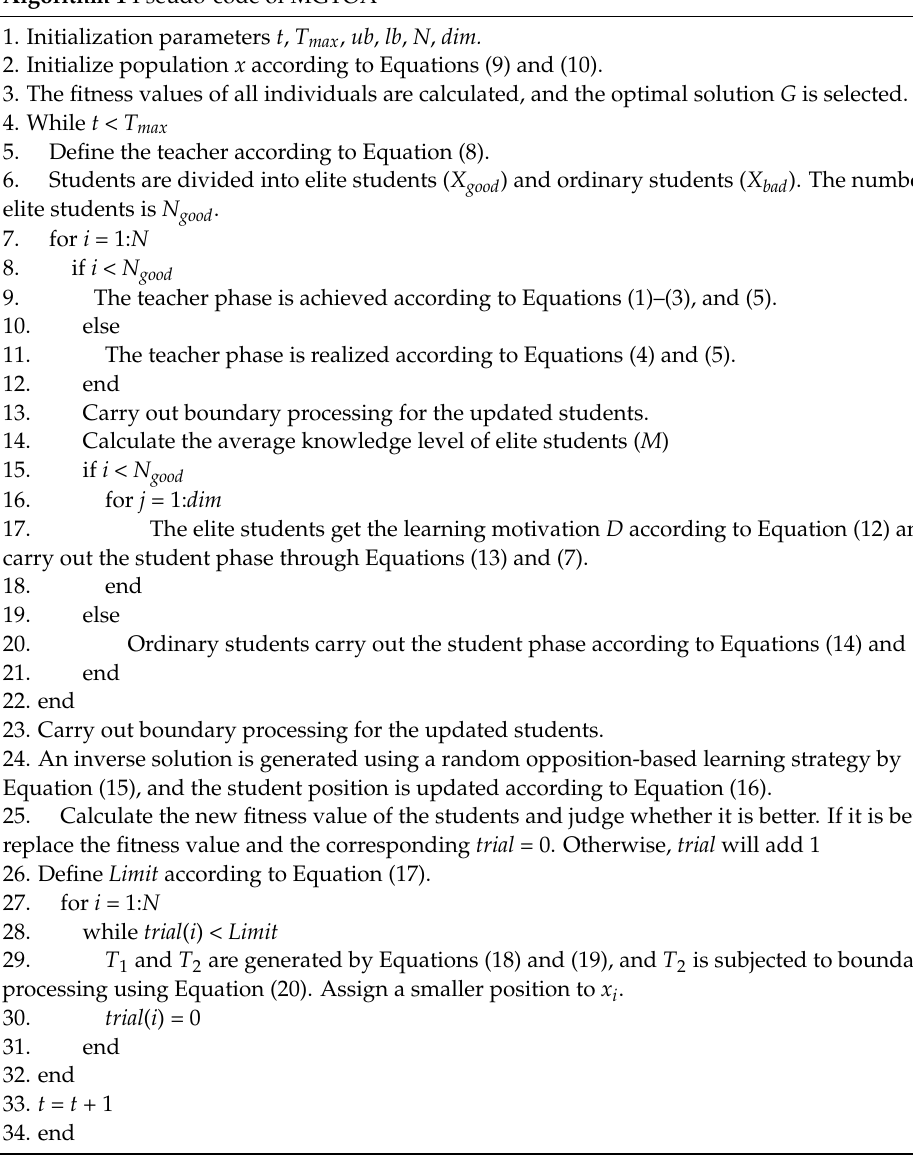
Algorithm 1 Pseudo-code of